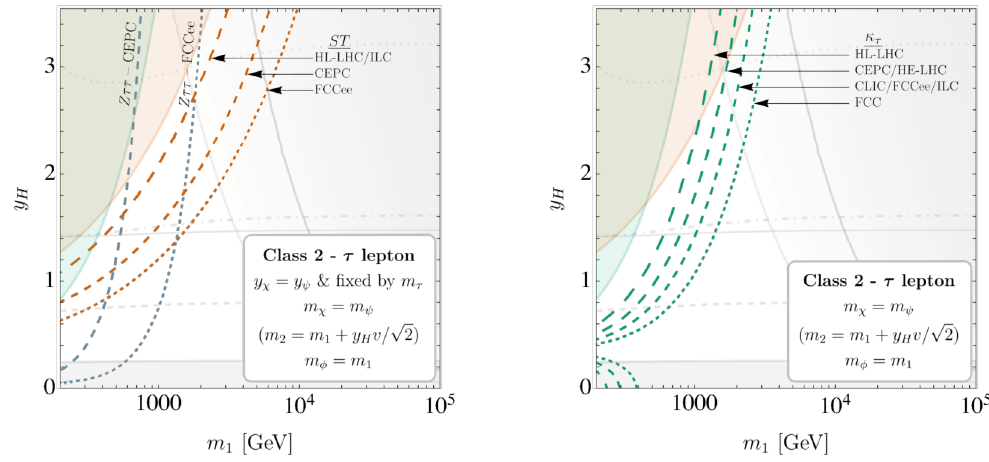
Figure 11. Projected 2 σ experimental sensitivities on the Class 2 τ -lepton benchmark model from future colliders, for the left slice of parameter space in fig.